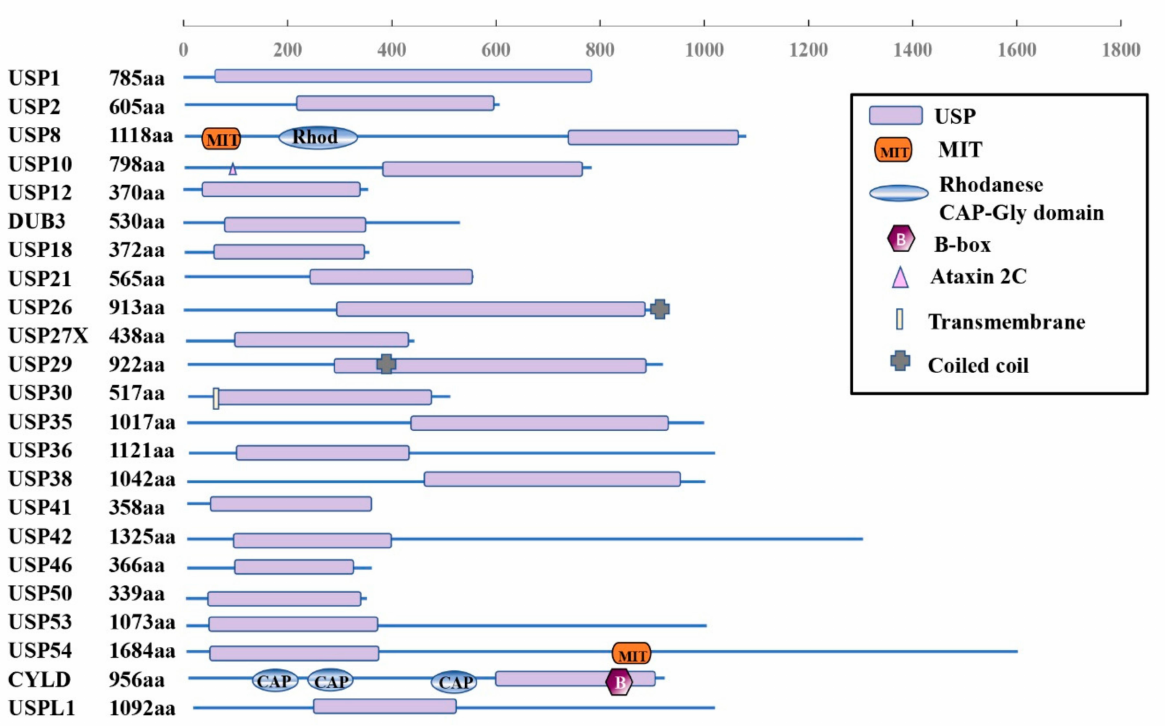
Figure 3. Schematic illustration of USP10-related subfamily